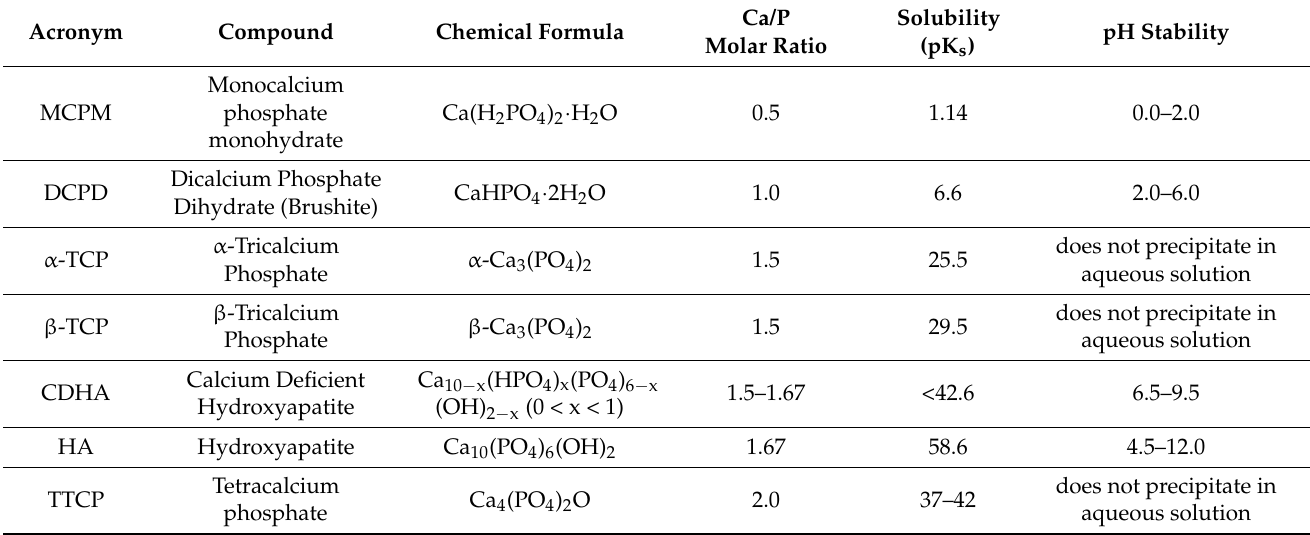
Table 3. Main calcium phosphates involved in CPC products.